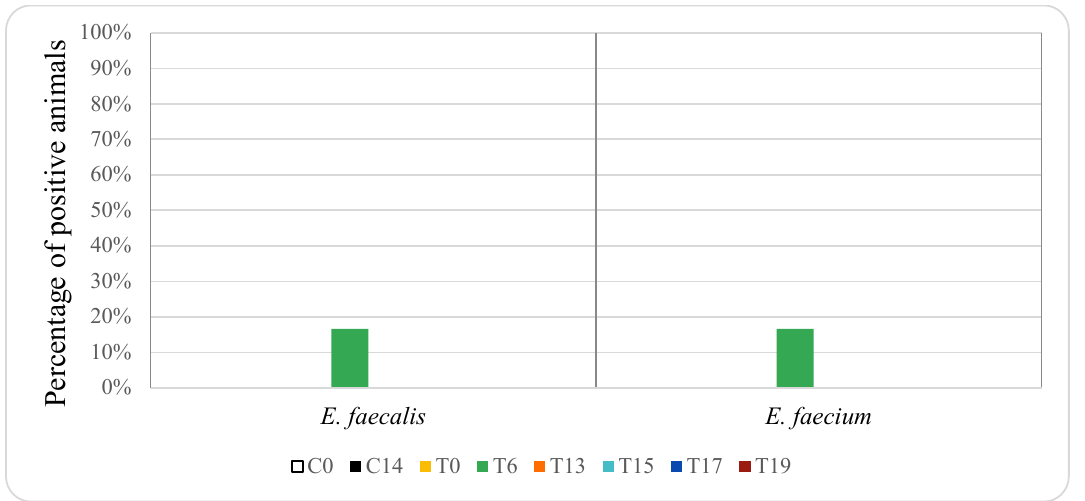
Figure 3. Effect of oxytetracycline treatment on vancomycin-resistant enterococci in pig genital samples. For group descriptions C0, C14, T0, T6, T13, T15, T17 and T19: see Table 1.